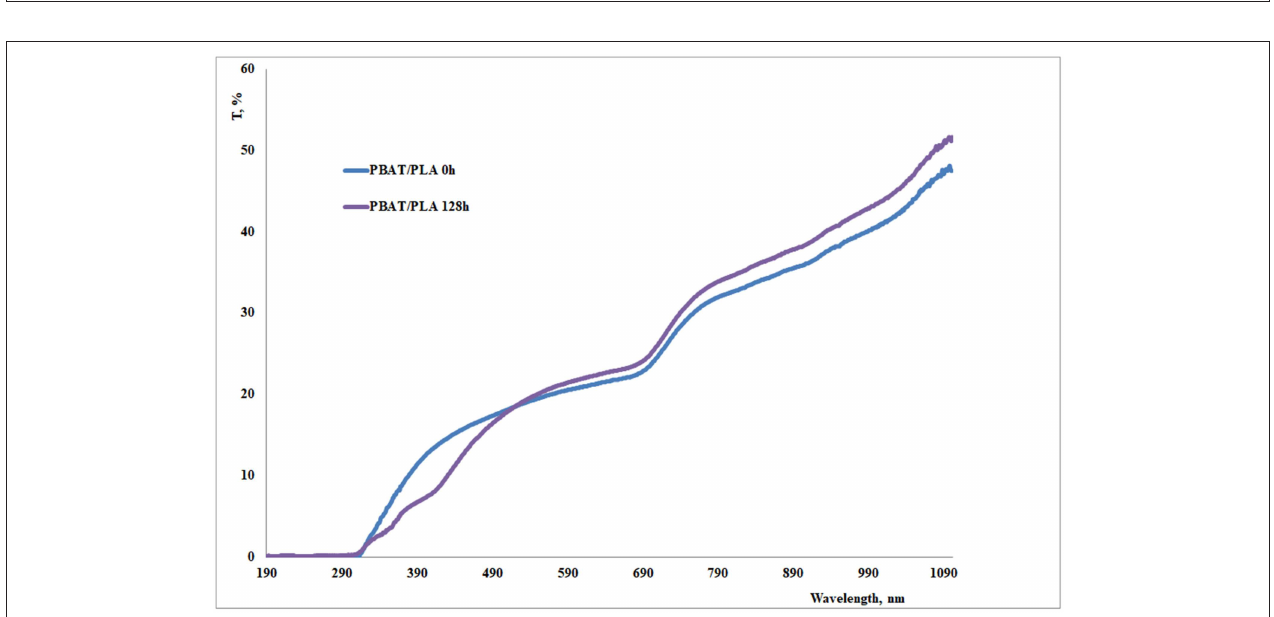
FIGURE 12 | UV spectra of pristine and 128h-irradiated PBAT/PLA blend.